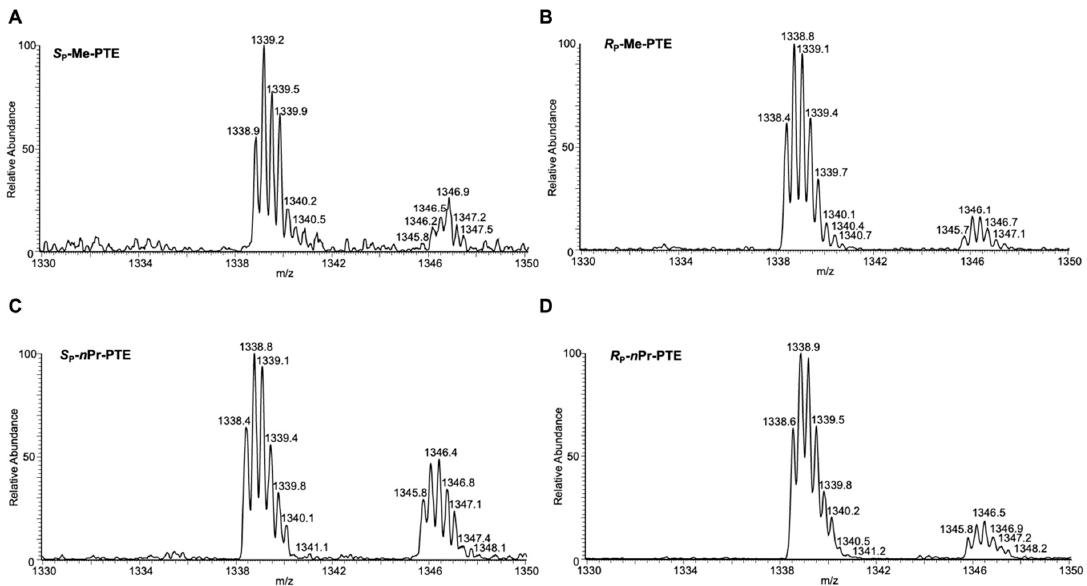
Figure 4. Higher-resolution “zoom-scan” ESI-MS for monitoring the [M-3H] 3 − ions of the restriction fragments of interest, i.e., 5 ′ -pCATGGCMNGCTAT-3 ′ (MN = TT, TG, TC and TA) from the transcription of S p -Me-PTE ( A ), R p -Me-PTE ( B ), S p -